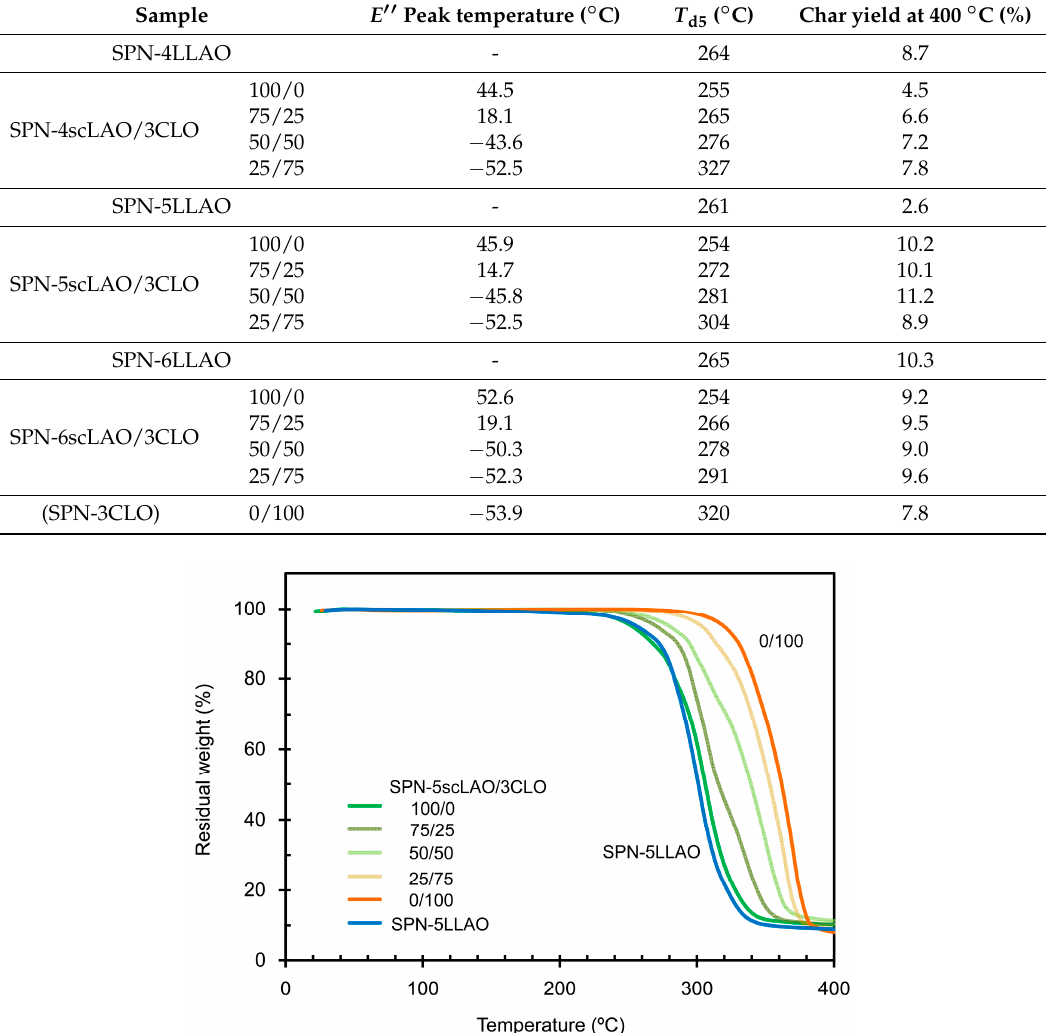
Figure 8. TGA curves of SPN-5scLAO/3CLOs (100/0, 75/25, 50/50, 25/75 and 0/100) and SPN-5LLAO.